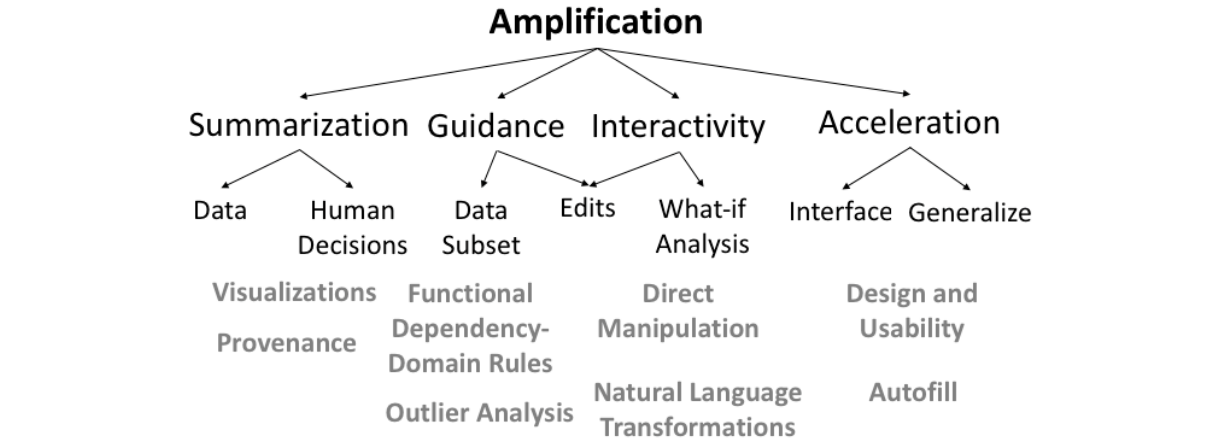
Figure 2. Taxonomy of expertise amplification: the first level shows the 4 dimensions that should be employed by a system for expertise